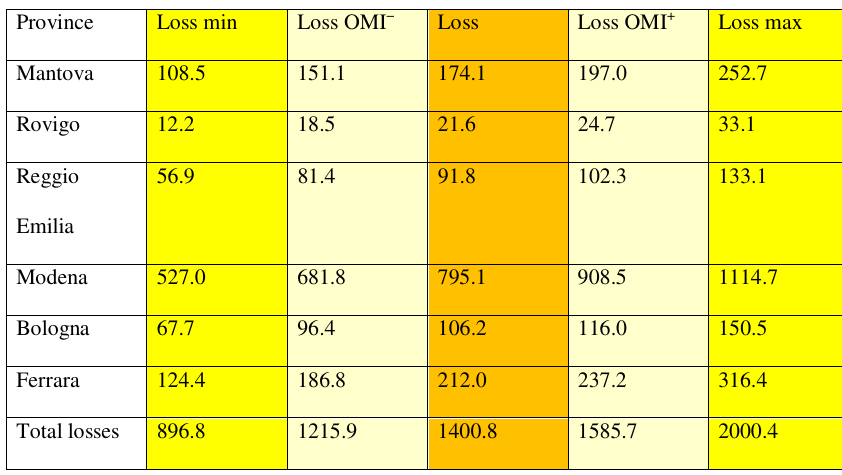
(b) Overall economic losses of some tested cases. The results (in million Euro) are provided for each province of the study